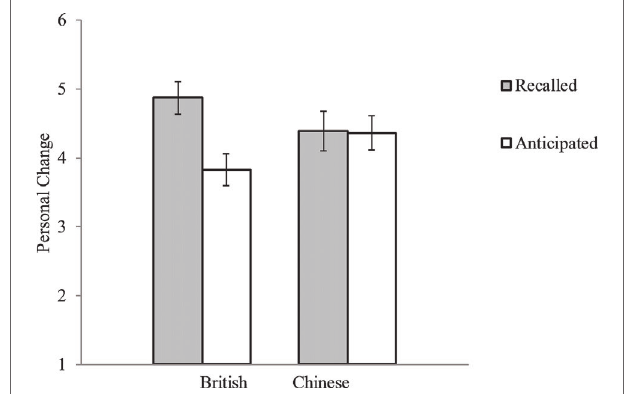
FIGURE 6 | British and Chinese directly reported personal changes in the last year and in the next year. Error bars represent standard